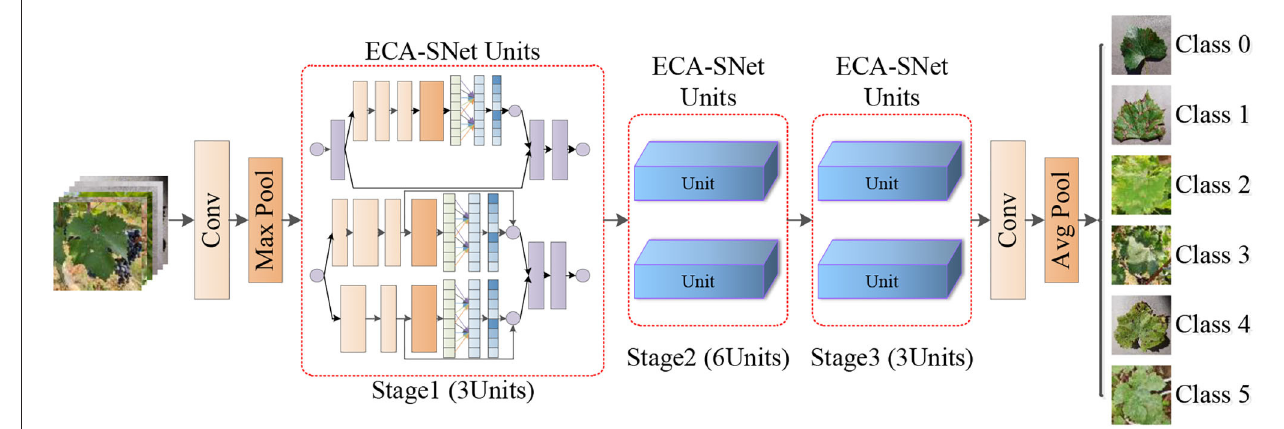
FIGURE 3 | The overall structure of